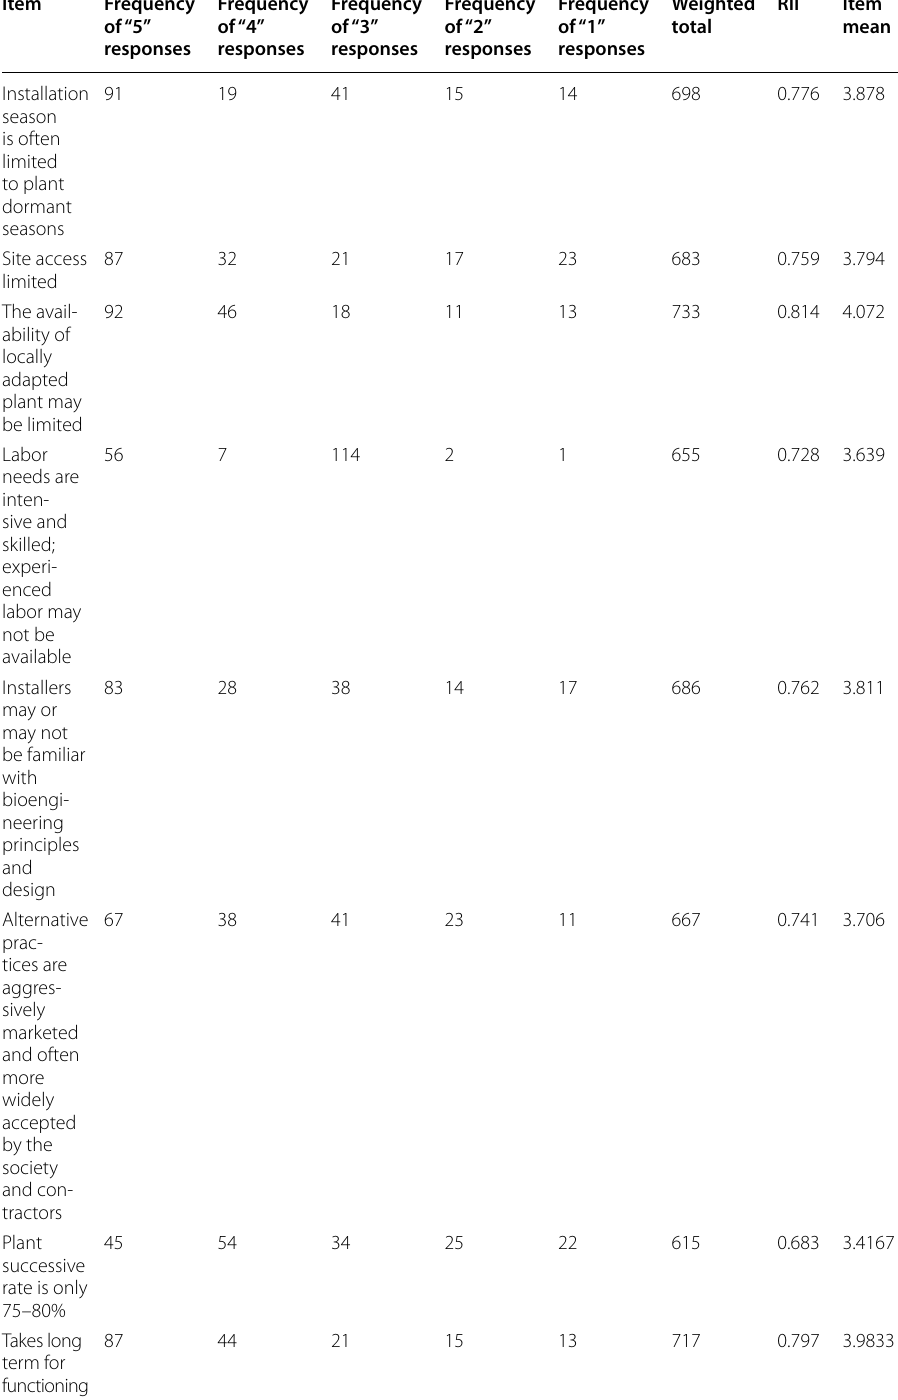
Table 8 Limitations of bioengineering technique ( n